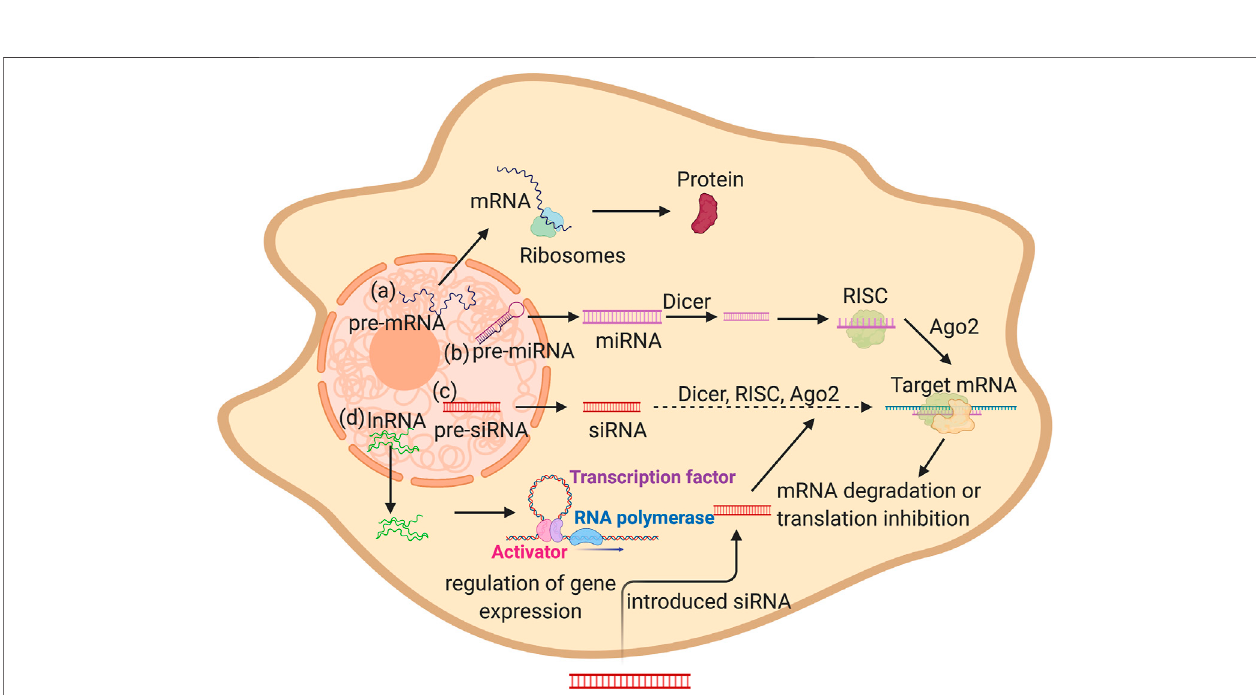
FIGURE1 | Schematic illustration showing different types ofRNA inmammalian cellsmRNA, miRNA, siRNA, and lnRN. (A) Premature mRNA gets exported to the cytoplasm then translated into protein by ribosomes. (B,C) pre miRNA and pre siRNA are produced in the nucleus and then gets exported to the cytoplasm then processed by Dicer followed by RISC complex formation, fi nally the miRNA or siRNA binds to the target sequence by complementation. This causes the degradation of the target RNA or translation block. (D) lncRNA are produced in the nucleus then exported into the cytoplasm in which they can regulate the gene expression (Created with